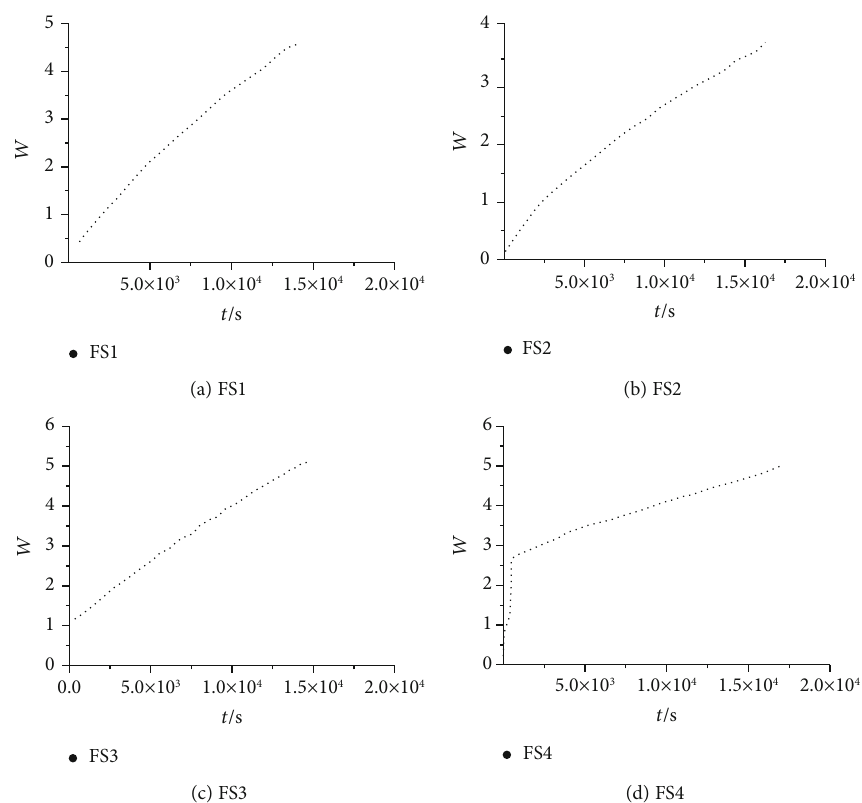
Figure 19: Pressure water absorption w – t curve of the siltstone